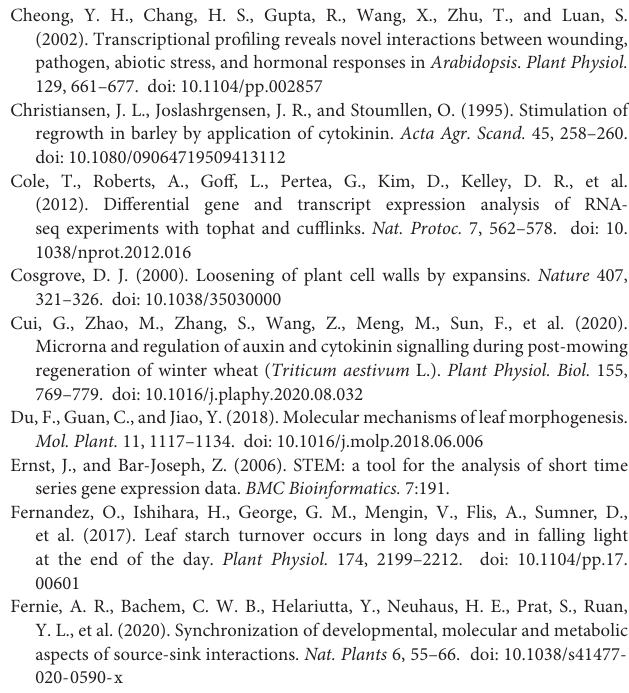
Supplementary Figure 1 | Standard curve of indole-3-acetic acid (IAA), indole-3-carboxaldehyde, and cis-zeatin (cZ). Supplementary Figure 2 | Trend clustering analysis of differentially expressed mRNAs and KEGG enrichment analysis of mRNAs in different classes. (A) Trend clustering analysis of differentially expressed mRNAs. (B–D) KEGG enrichment of mRNAs in classes I, II, and III. The expression of mRNAs in class I was changed at 2 h but not at 24 and 72 h after mowing. The expression of mRNAs in class II did not change at 2 h but changed at 24 or 72 h after mowing. The expression of mRNAs in this class was altered at 2, 24, and 72 h after mowing. Supplementary Figure 3 | KEGG enrichment of differentially expressed targeted mRNAs of differentially expressed lncRNAs. Supplementary Figure 4 | Correlation analysis of the expression of lncRNAs and their target mRNAs. The horizontal and vertical coordinates represent the FPKM values of mRNAs and lncRNAs, respectively. T0, T1, T2, and T3 means the sample was harvested at 0, 2, 24, and 72 h after mowing, respectively. Supplementary Table 1 | Primers for qRT-PCR. Supplementary Table 2 | All identified differentially expressed lncRNAs and annotation in GO and KEGG analysis. Supplementary Table 3 | All identified differentially expressed mRNAs and their annotation in GO and KEGG database. Supplementary Table 4 | Expression trend cluster analysis of differentially expressed mRNAs. Supplementary Table 5 | Interaction analysis between differentially expressed mRNAs and differentially expressed lncRNAs. Supplementary Video 1 | Indoor simulation of post-mowing regeneration of wheat. The wheat seedlings were placed in a growth chamber at a temperature of 15/20 ◦ C and a 10/14 h dark/light